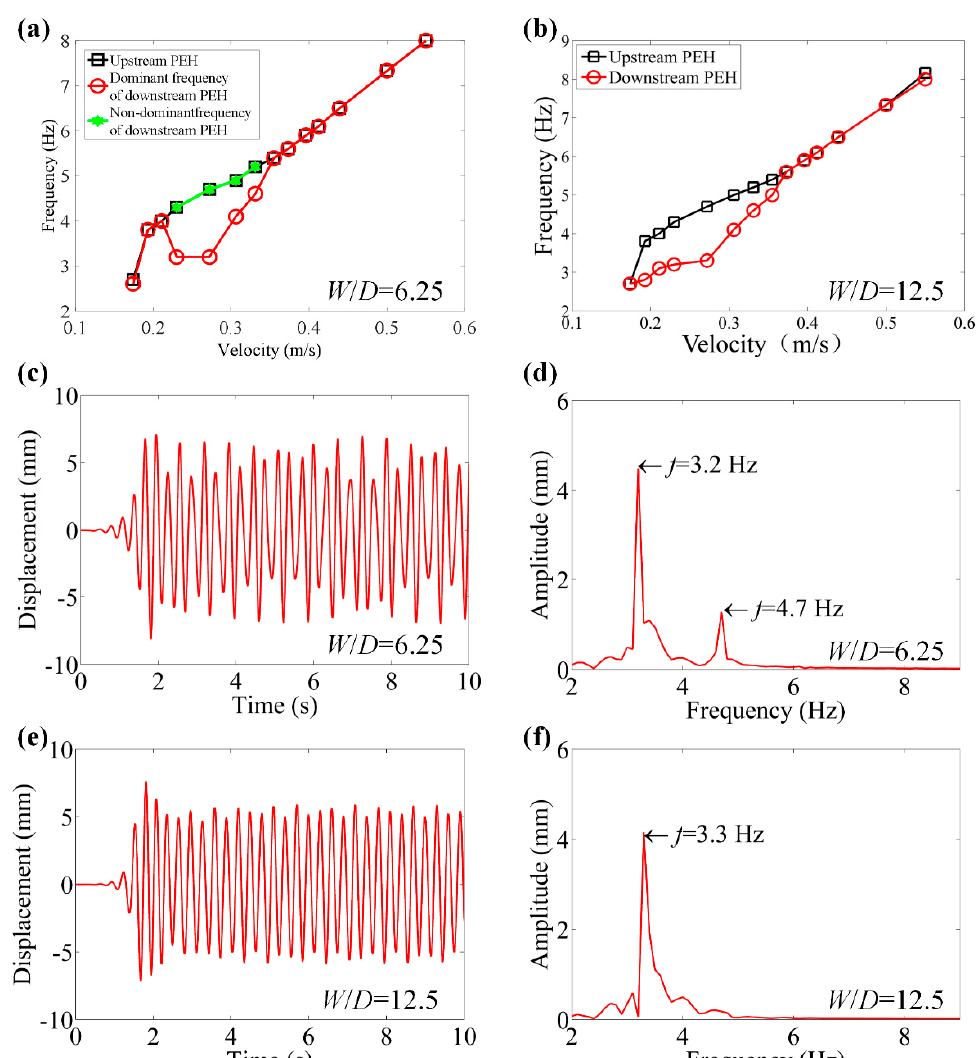
Figure 7. Vibration frequencies of the PEHs versus velocity when W / D = 6.25 and W / D = 12.5. ( a ) Vibration frequencies when W / D = 6.25. ( b ) Vibration frequencies when W / D = 12.25. ( c ) Vibration response when W / D = 6.25 and U = 0.272 m/s. ( d ) Fast Fourier transform (FFT) when W / D = 6.25 and U = 0.272 m/s. ( e ) Vibration response when W / D = 12.25 and U = 0.272 m/s. ( f ) FFT when W / D = 12.25 and U = 0.272 m/s.